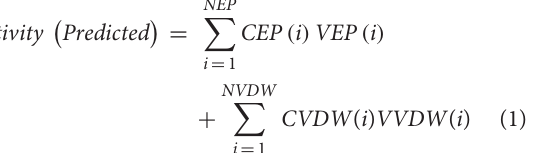
TABLE 2 | Experimental activities and predicted activities of compounds by 3D-QSAR model.